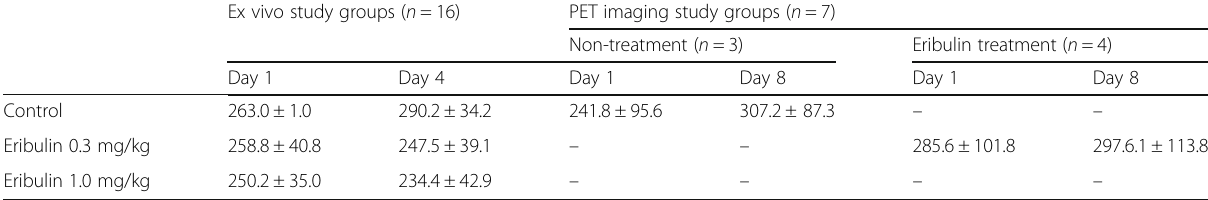
Table 2 Tumor volume (mm 3 ) Ex vivo study groups ( n =